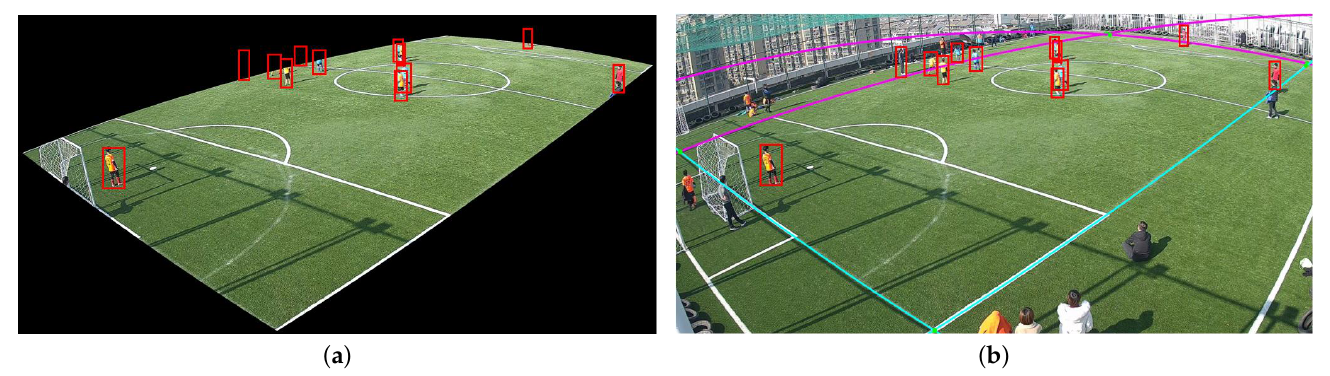
Figure 2. (1) Panels ( a , b ) represent two different region-limitation methods. The red bounding-boxes identify the targets inside the field. (2) Method ( a ) removed the off-field influence and simultaneously erased the information of the players standing on the edge of the field. (3) Method ( b ) can effectively distinguish between on-field and off-field characters without losing useful information. (4) The α of purple quadratic curves are 1, and the α of cyan quadratic curves are − 1.